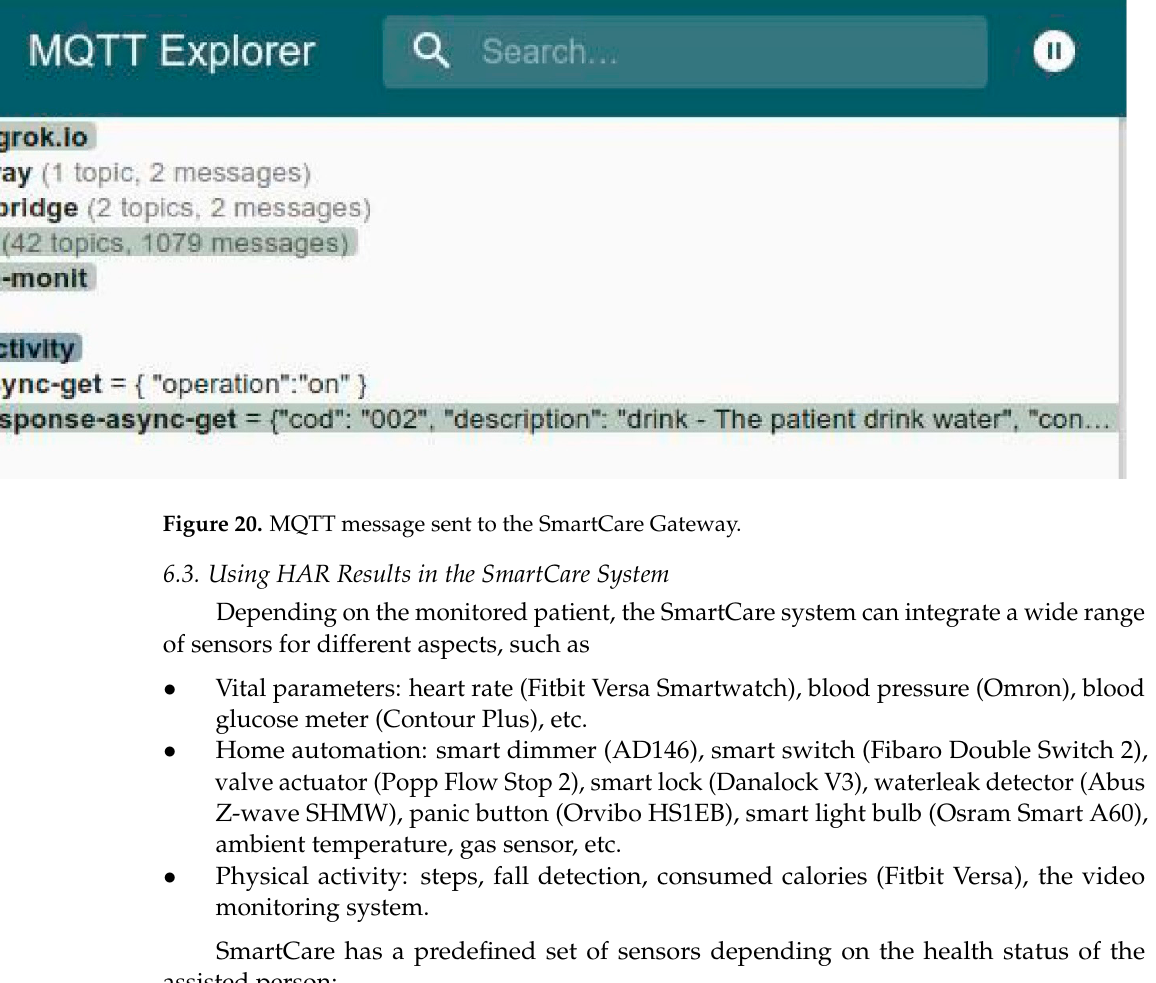
Figure 19. Activity detection result.